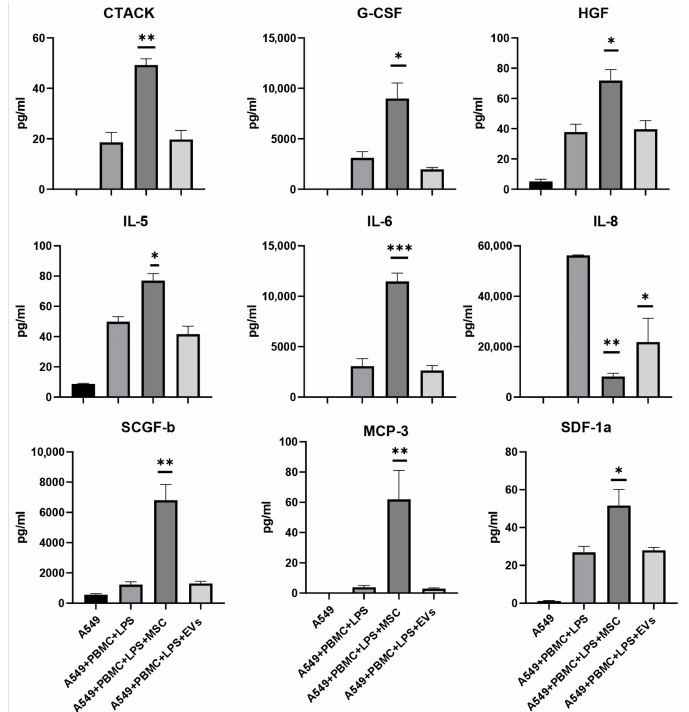
Figure 10. The effect of MSC and EVs on cytokine/chemokine concentrations in the conditioned medium from the model system after 24 h treatment. The data are presented as a mean ± SEM, n = 4. * p < 0.05, ** p < 0.01, *** p < 0.001 significance from A549 + PBMC + LPS is assessed by a one-way ANOVA with Tukey’s multiple comparison